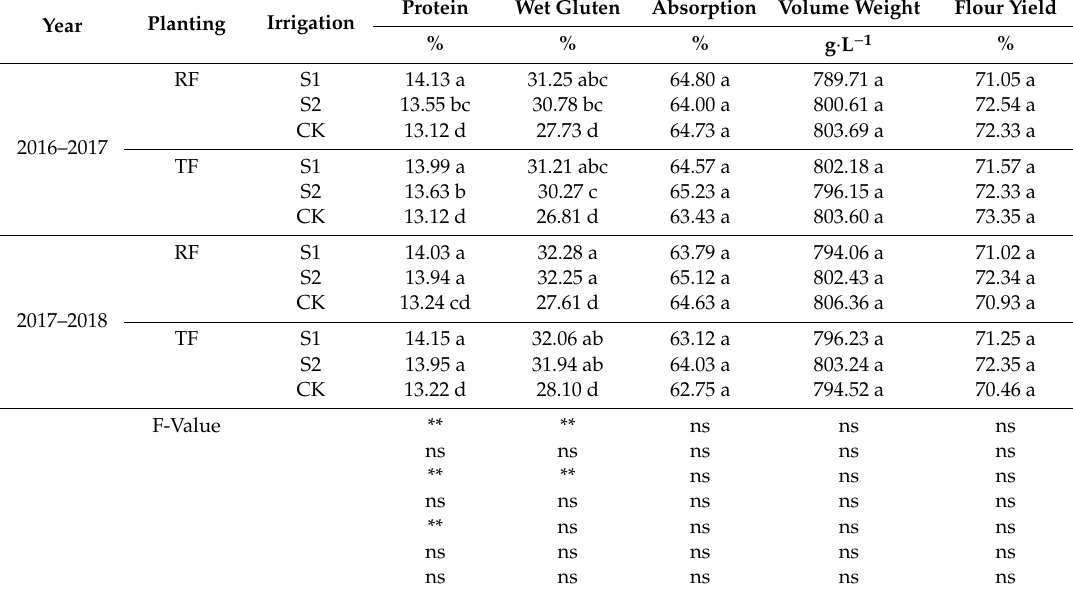
Table 3. E ff ect of two planting systems (RF and TF) and three irrigation levels (S1, S2, and CK) on the grain quality of